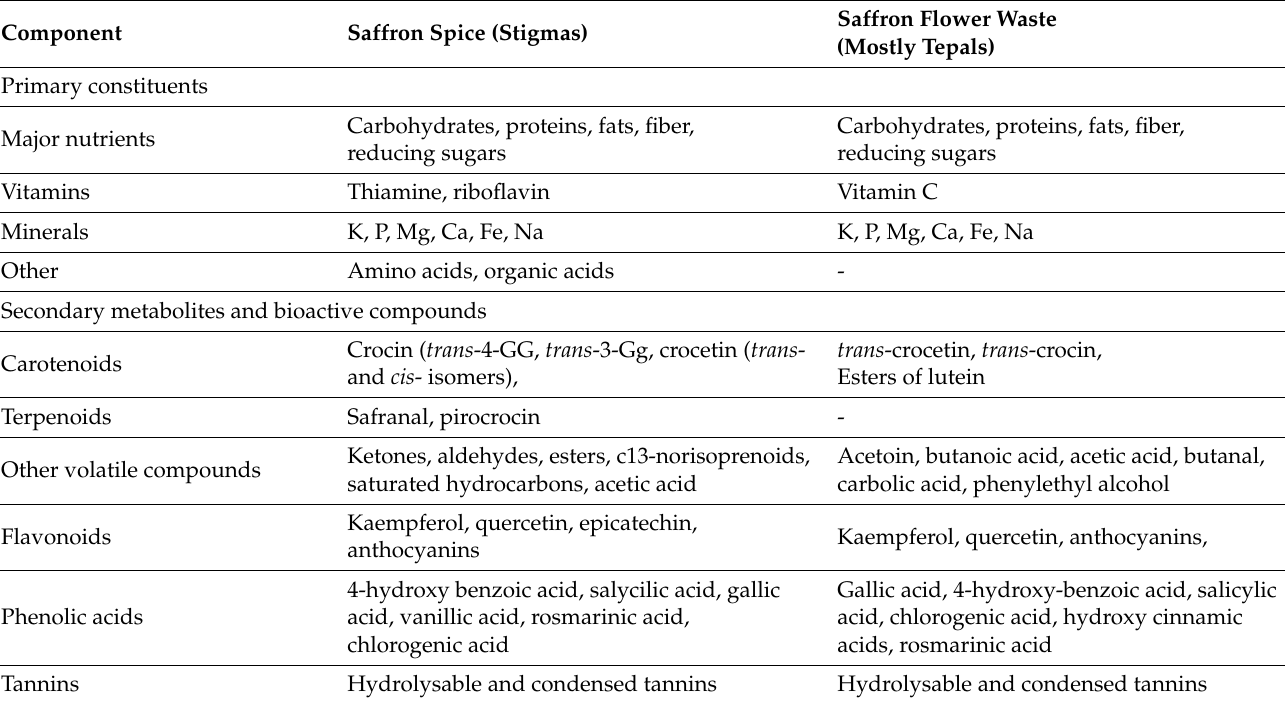
Table 1. Summary of the main constituents identified in saffron